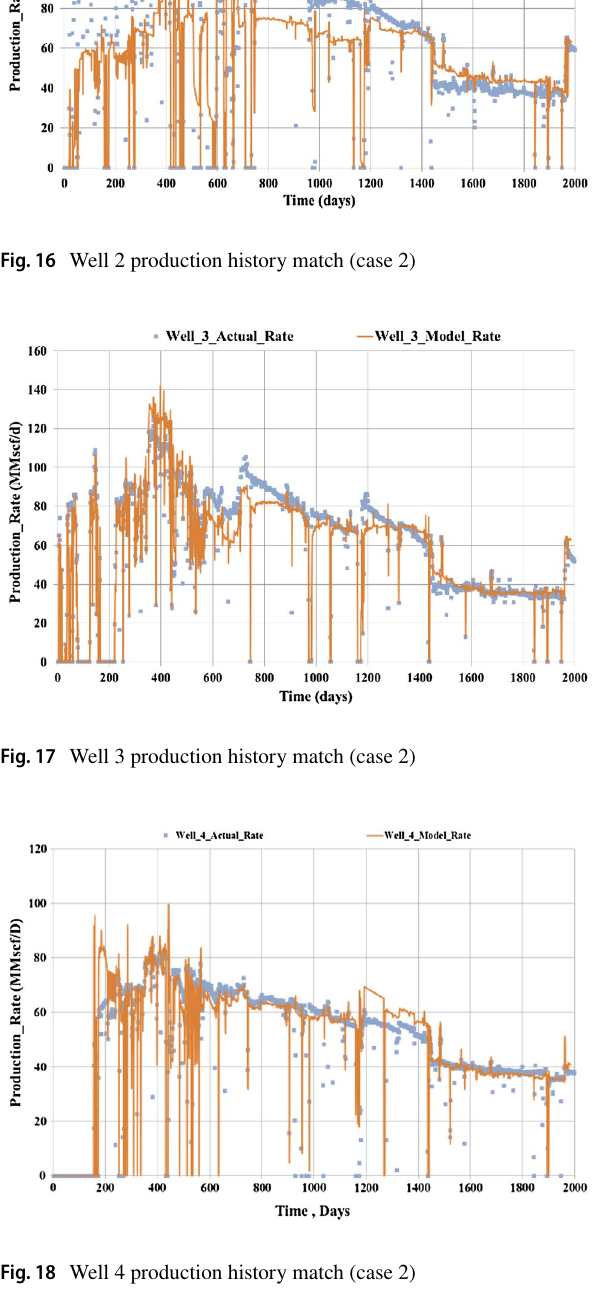
Fig. 18 Well 4 production history match (case